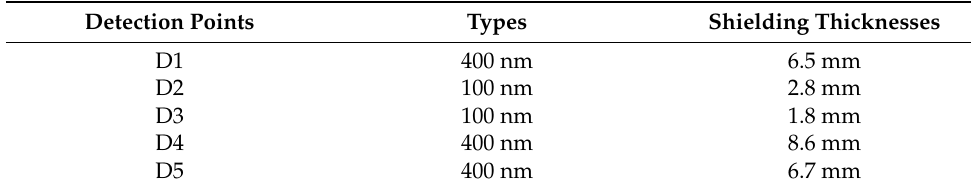
Table 5. Equivalent shielding thickness corresponding to each sensor.